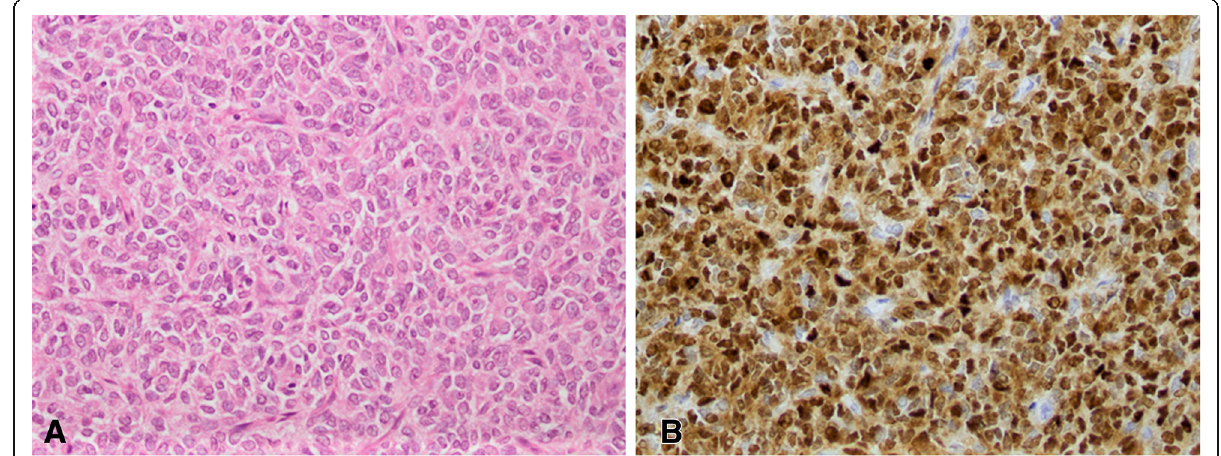
Fig. 1 Classic clear cell sarcoma of kidney ( a ), showing diffuse strong Cyclin D1 positivity ( b